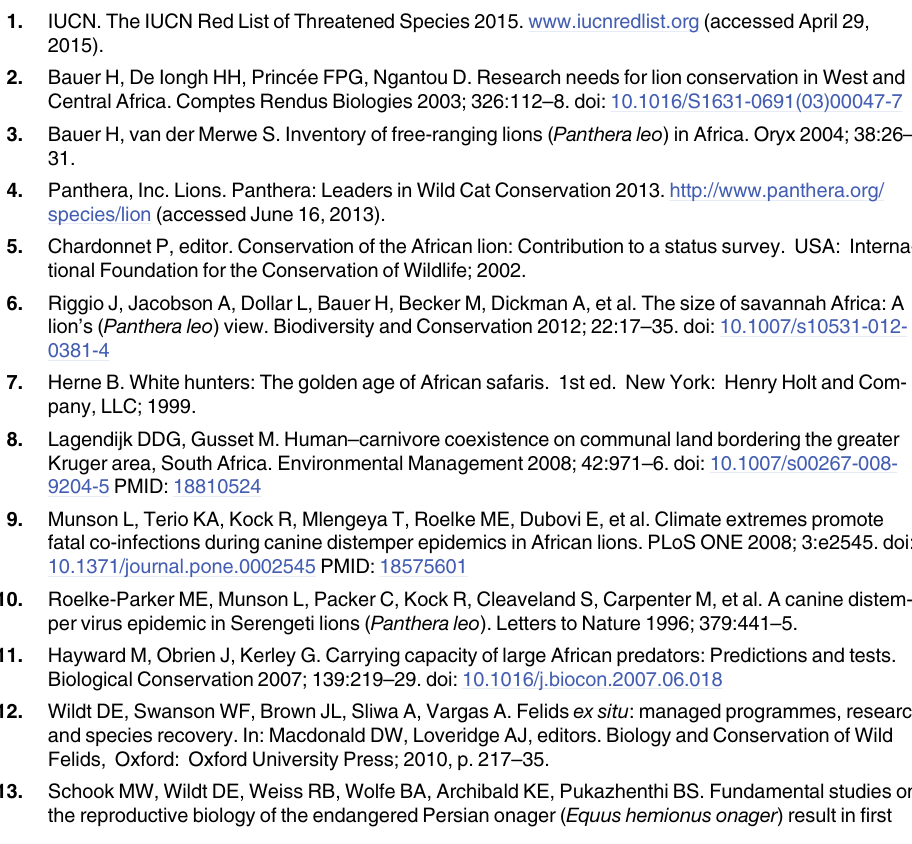
S1 Table. Demographic information on study animals (N = 38).